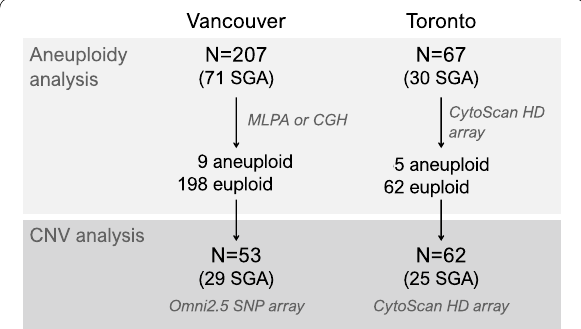
Fig. 1 Schematic of the study design, including methods and sample sizes used in both cohorts in this study. Only placentas that were euploid following aneuploidy analysis were used for CNV analysis. Genetic assessment methods are italicized. CGH comparative genomic hybridization, MLPA multiplexed ligation‑dependent